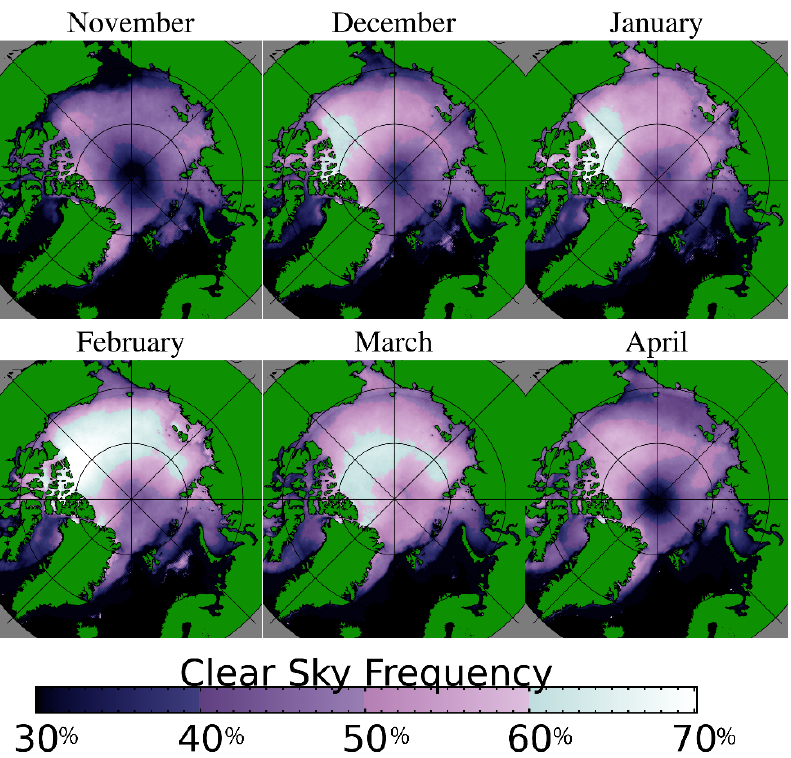
Figure 4. Winter clear sky frequency by month, reported as the percentage of probably clear or confidently clear overpasses in the MODIS cloud mask [32,33] divided by the number of total overpasses from November 2002 through April 2020. Only overpasses over continuous sea ice are considered.